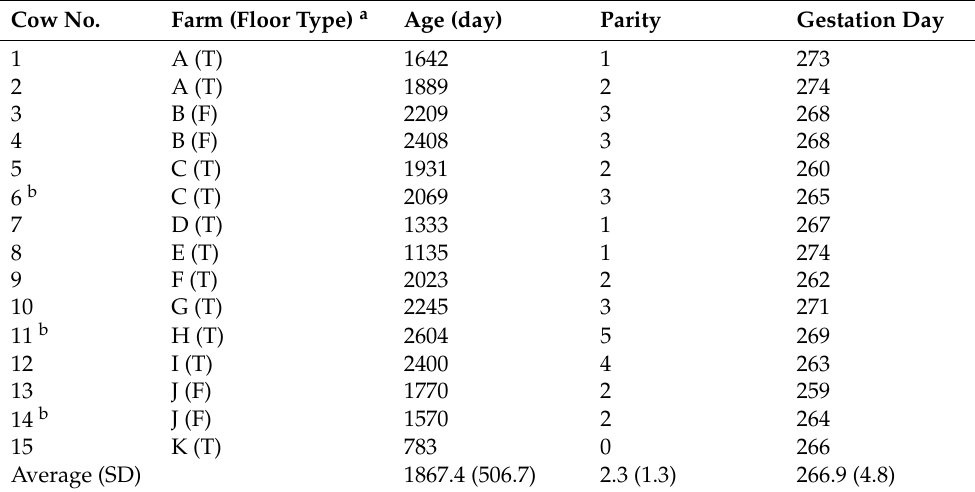
Table 1. Summary of the clinical records of the present cases on the operative days.